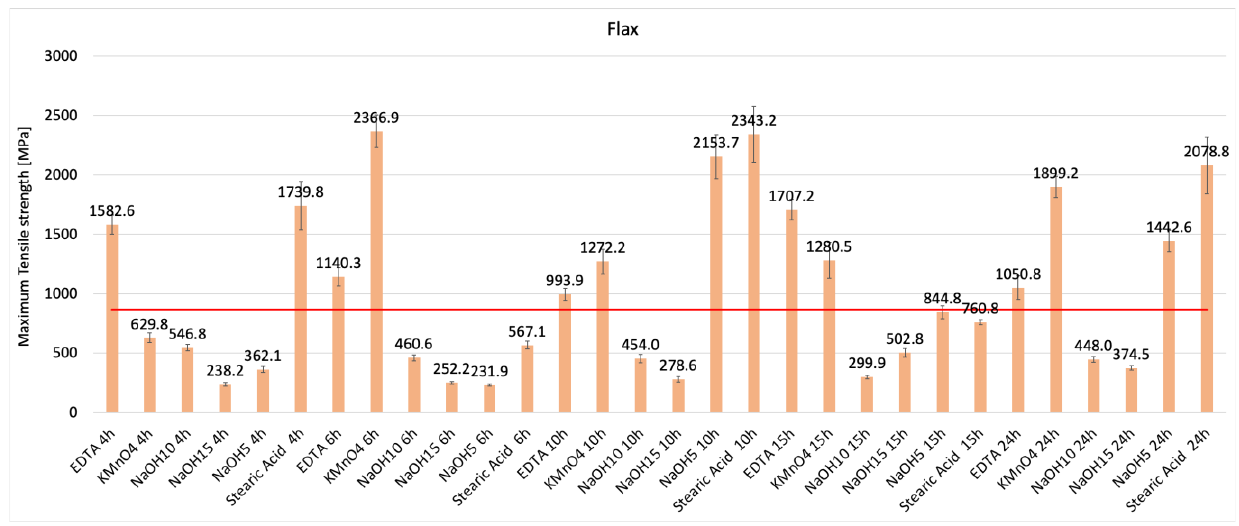
Figure 8. Maximum tensile strength obtained for each treatment on flax fibres.